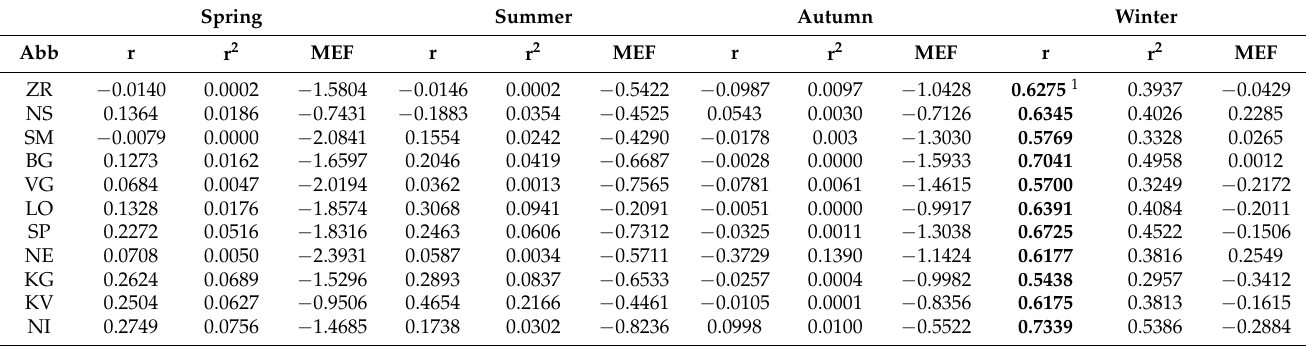
Table 8. Seasonal results from linear regression models for Tx90.